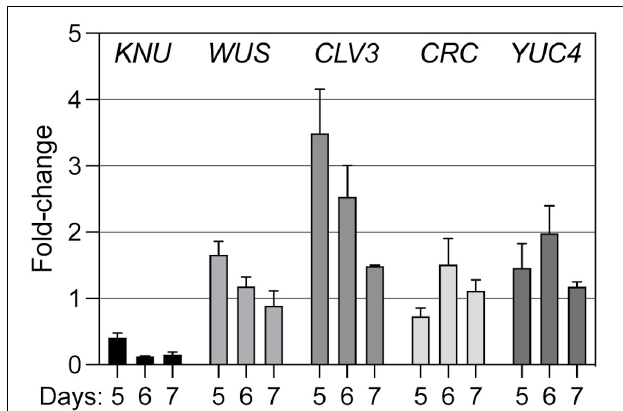
FIGURE 4 | Effect of amiRNA-mediated perturbation of KNU on the expression of meristem regulators. A p35S::KNU-amiRNA transgene was introgressed into pAP1::AP1-GR ap1-1 cal-1 plants. Flower development in this line, as well as in pAP1::AP1-GR ap1-1 cal-1 plants that did not express the KNU-amiRNA, was induced by dexamethasone treatment and floral buds were collected 5, 6, and 7 days after the treatment. Transcript levels of different meristem regulators (as indicated) were determined by RT-qPCR in four (5 and 6 days) or three (7 days) biologically independent sets of samples. Fold change expression values in the amiRNA-expressing lines relative to the lines with normal KNU activity are shown. Bars indicate SEM.